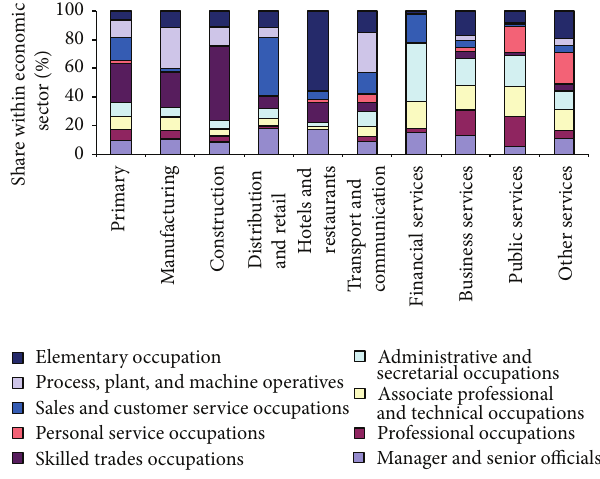
Figure 4: Occupational breakdown within economic sector in the Tyne and Wear region based on Office for National Statistics [7].